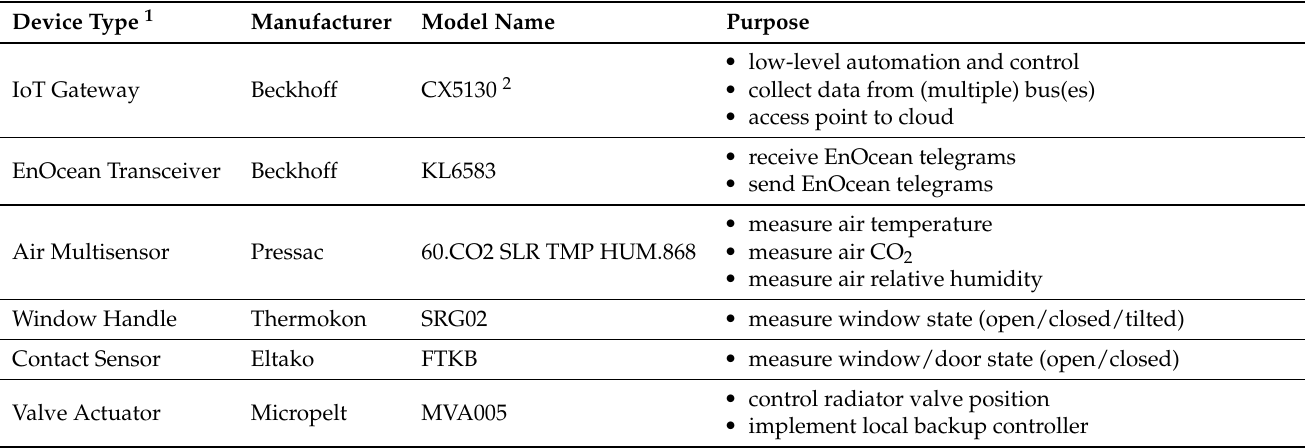
Table 4. Overview of selected physical EnOcean-based devices, including manufacturer, model, and